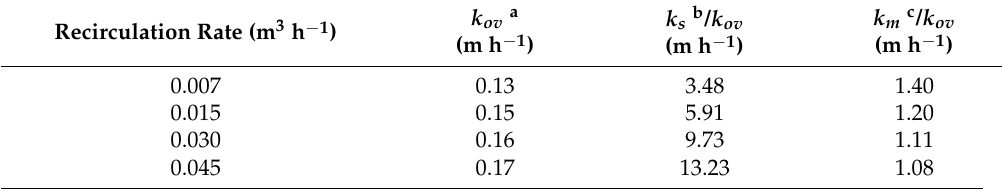
Table 4. Calculated mass transfer coefficients for synthetic digestate.